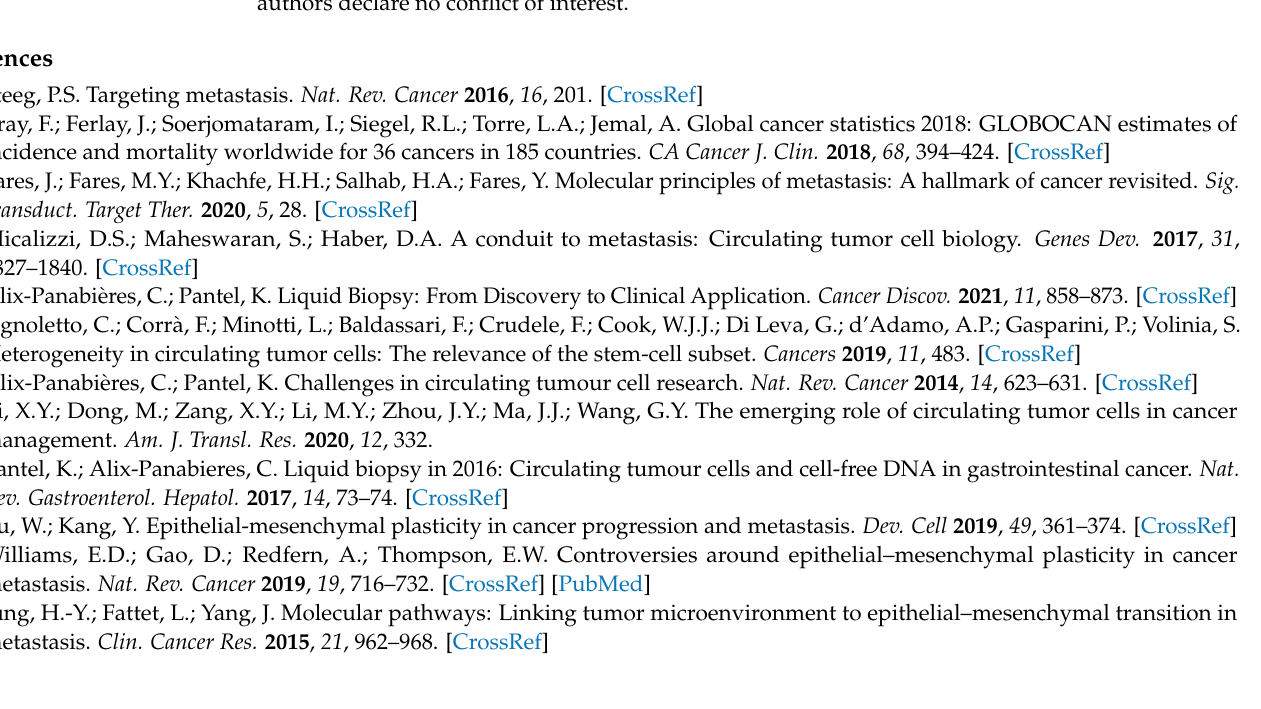
cancer patient. Figure S2: GeneChip assay of SIX1 mRNA level in HT-29, SW620, and CTC cell clones. Figure S3: EZRIN gene expression profile by GeneChIP assay. Figure S4: GeneChip assay of GRHL2 mRNA level in CTC-MCC lines and SW620 cells. Figure S5: RAB25 gene expression profile by GeneChIP assay. Table S1: The sequence of the forward and reverse primers used for RT-qPCR